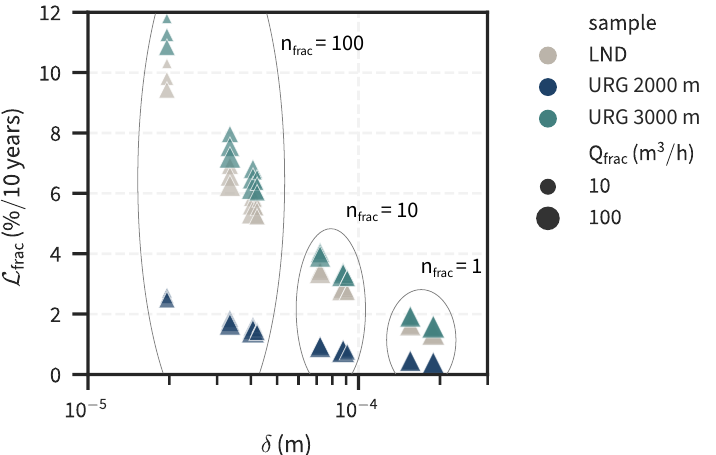
Figure 5. Permeability loss of the fracture layer ( L frac ) is dependent on the fracture half-aperture ( δ ), amount of fractures ( n frac ), flow rate ( Q frac ), and fluid sample, i.e., fluid chemistry. The relationships are shown for all scenarios after the final simulation time of ten years.